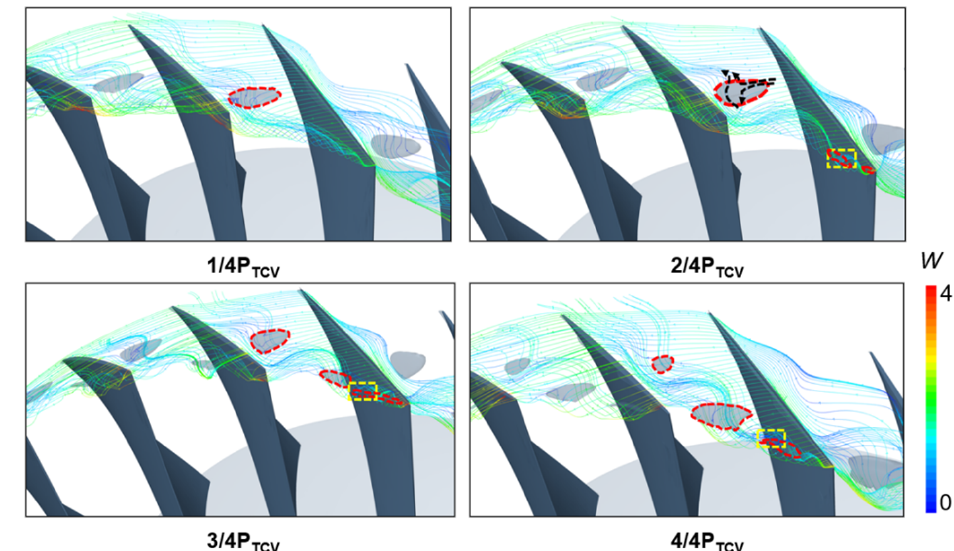
Figure 18. Unsteady streamlines from tip clearance with the iso-surface of Ma r = 0.2, P TCV is the period of the TCV (tip clearance vortex) shedding.